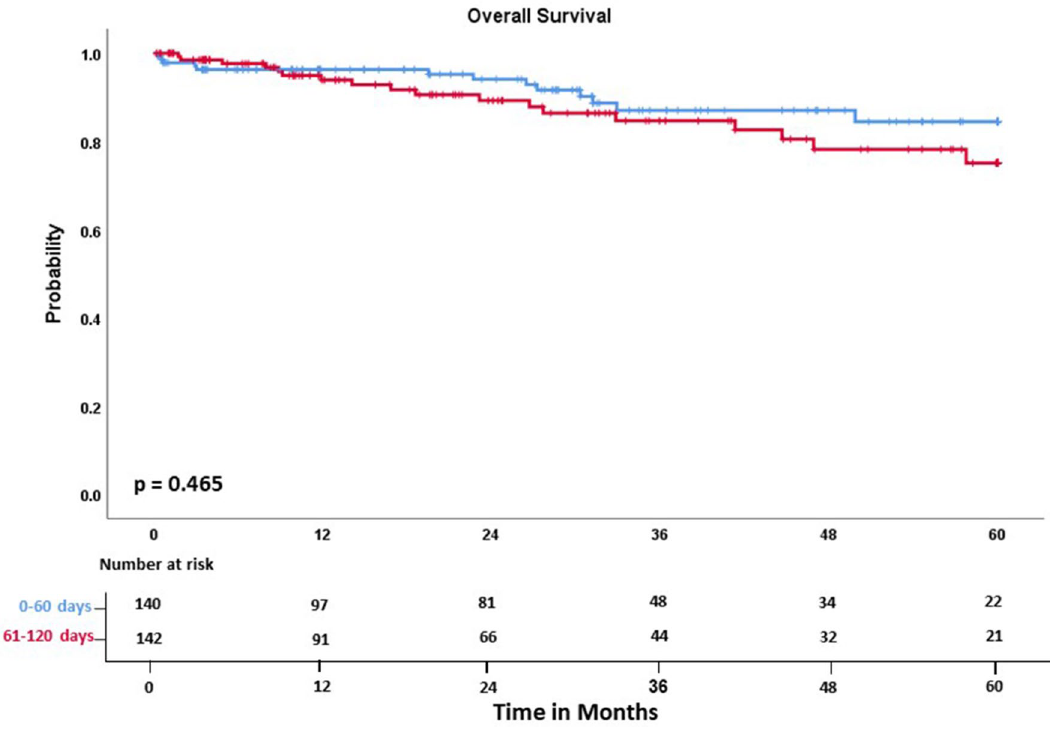
Figure 2. Overall survival for all patients did not show any difference between group A and